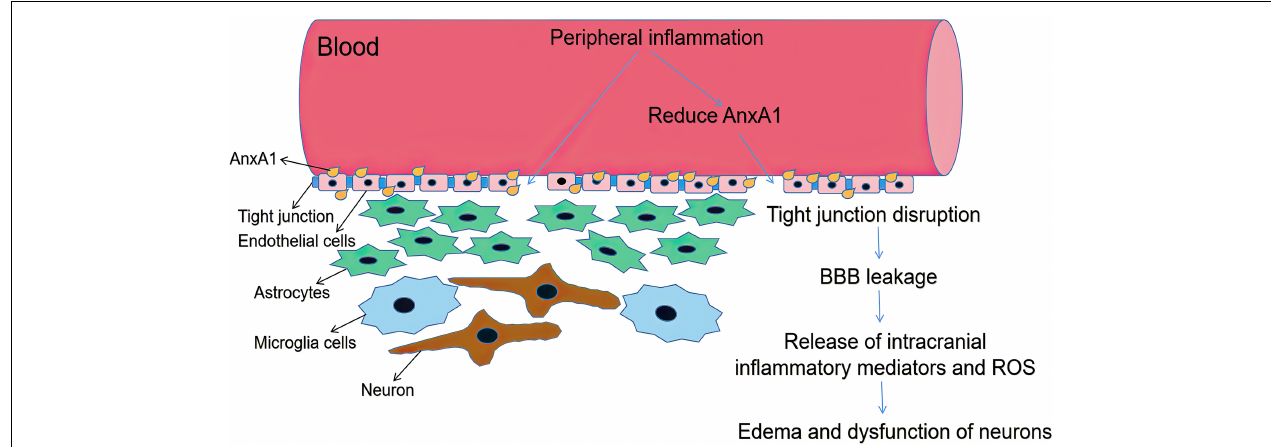
FIGURE 2 | Schematic diagram illustrating BBB dysfunction. ANXA1 is an indispensable part of BBB, which mainly expressed by brain microvascular endothelial cells close to plasma membrane (Gussenhoven et al., 2019). Systemic inflammation can increase BBB permeability by reducing AnxA1, with increased paracellular permeability and decreased TJ protein expression. Decline in BBB integrity triggers glial activation thus release intracranial inflammatory mediators and ROS. Then it causes brain edema and dysfunction of